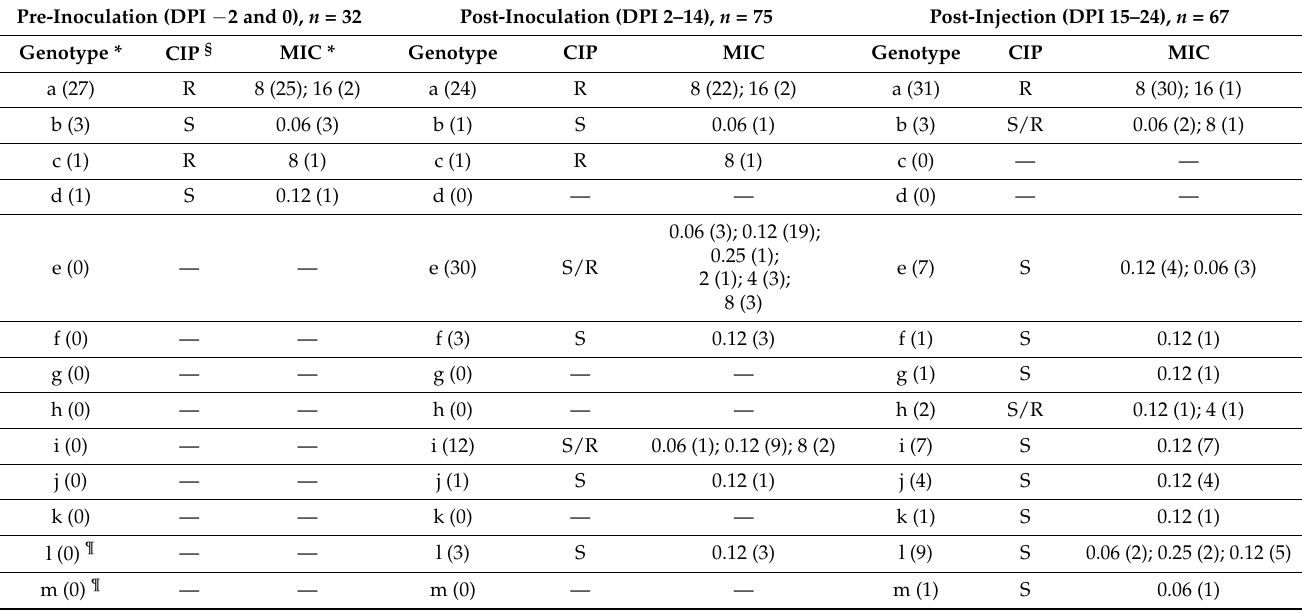
Table 2. PFGE genotypes and ciprofloxacin susceptibility of C. jejuni isolates from calves in Group 2 and Group 3 obtained throughout the study #